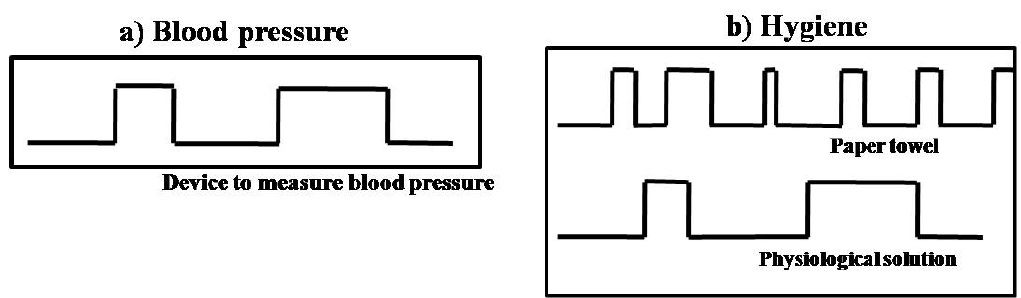
Figure 3. Three roaming beats representations ( a ) Roaming beat related to blood pressure activity; ( b ) Roaming beat related to hygiene